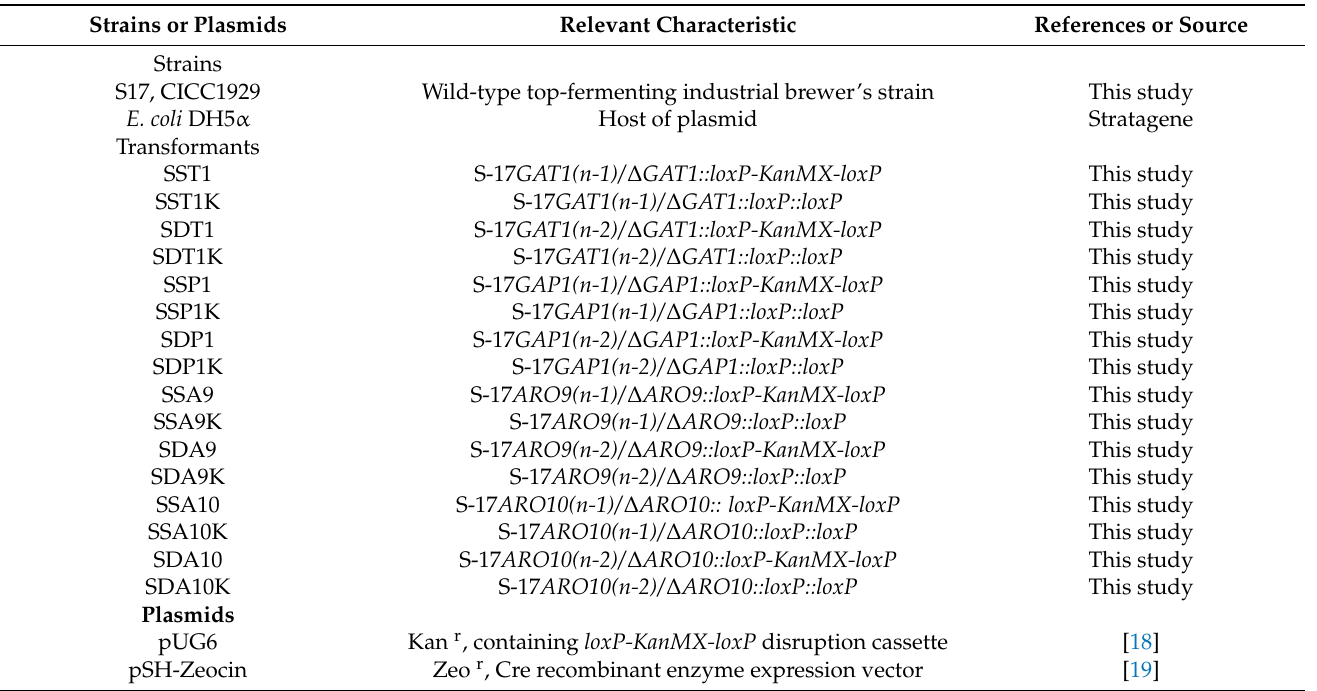
Table 1. Strains and plasmids used in the current